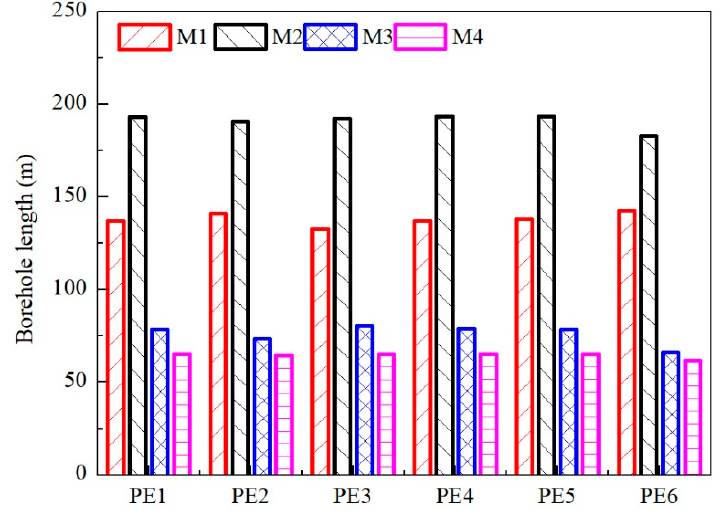
Figure 9. Borehole length calculated by different sizing methods using different PE results.